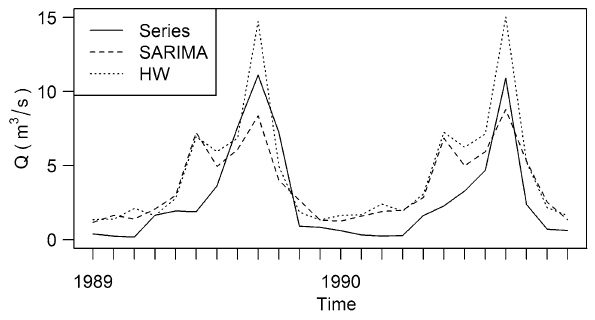
Fig. 7 Observed and forecasted mean monthly flow for the period